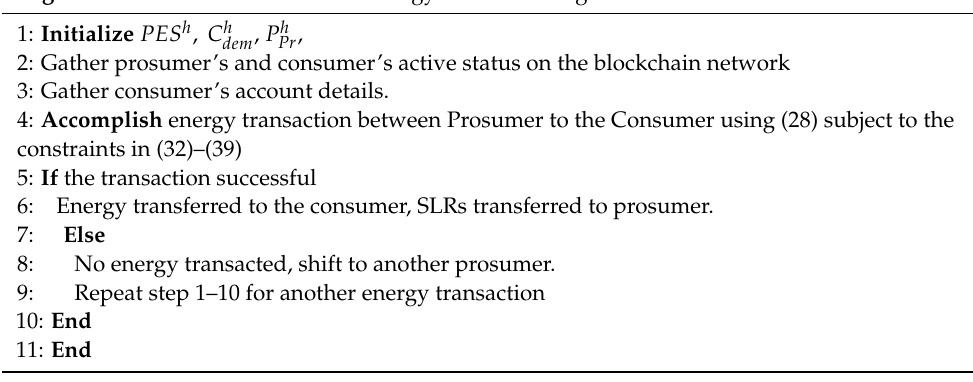
Algorithm 3 Blockchain-based P-C energy transaction algorithm